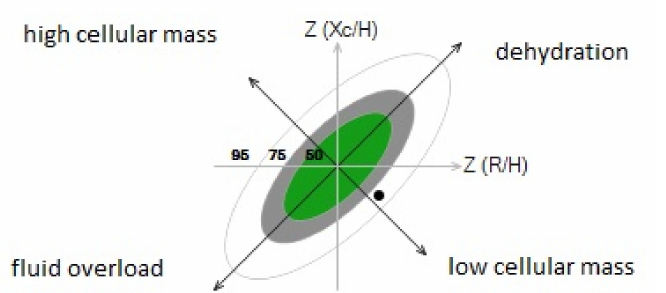
Figure 1. R/Xc graph provided by bioimpedance vector analysis according to the method of Piccoli et al. [12]. Patients were classified as malnourished when the tip of the impedance vector was within the lower right quadrant outside the 75th percentile of the tolerance ellipse along the horizontal axis (black dot in the